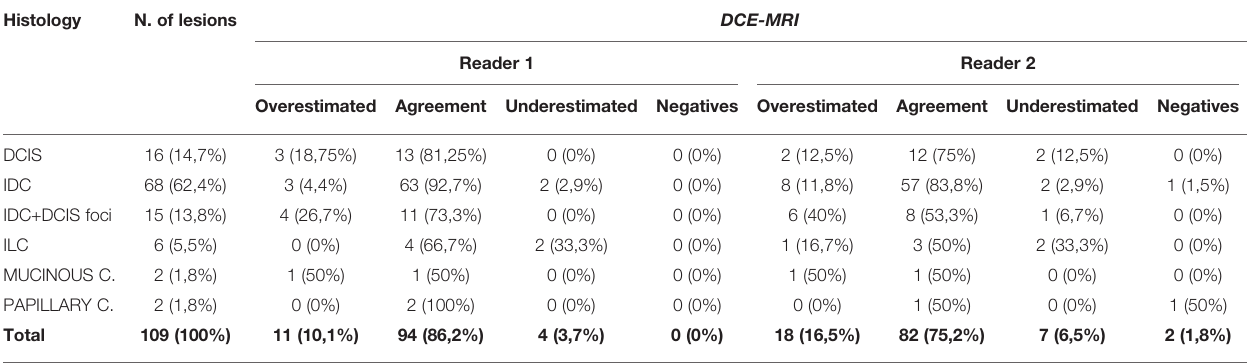
TABLE 2 | Concordance in terms of lesion size assessment of the malignant lesions detected with DCE-MRI and histology. Histology N. of lesions DCE-MRI Reader 1 Reader